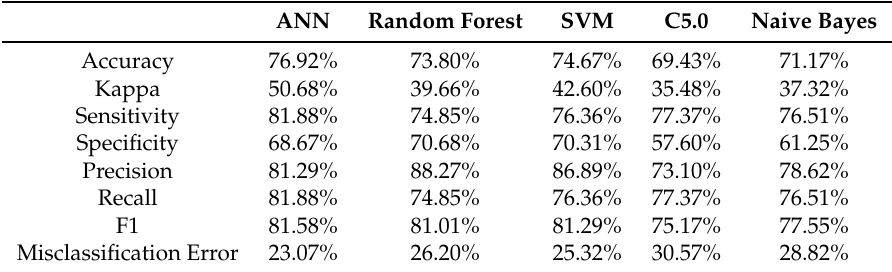
Table 1. Evaluation criteria for Diabetics prediction before implementing Genetic algorithm.